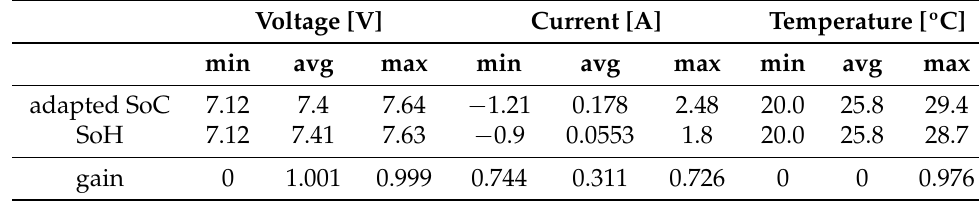
Table 7. Battery 2 during a month of simulation: Case 1.